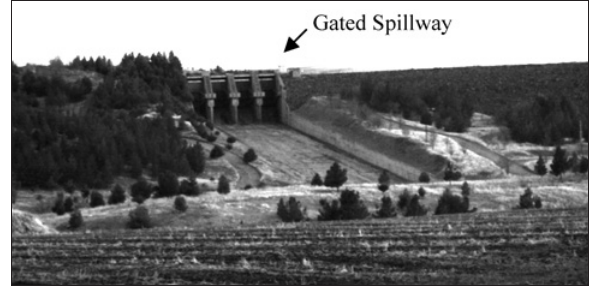
Fig. 3. Gated spillway structure of Goksu dam